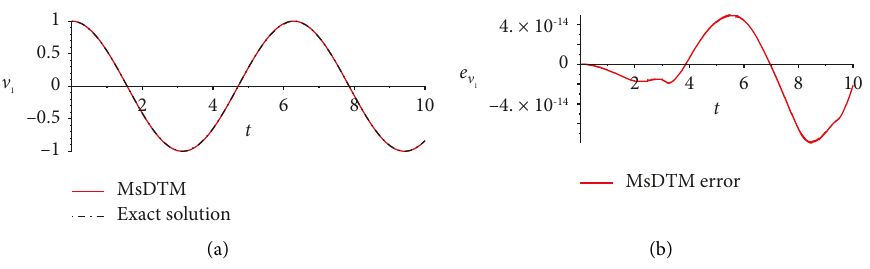
Figure 3: The approximate solution component v